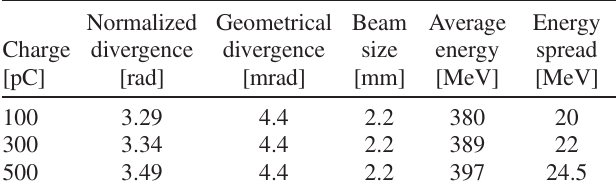
TABLE I. Space charge effects in the drift space: beam parameters after 50 cm of free propagation simulated using GPT